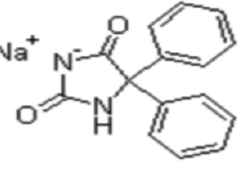
dilution. Figure 1. Chemical structure of